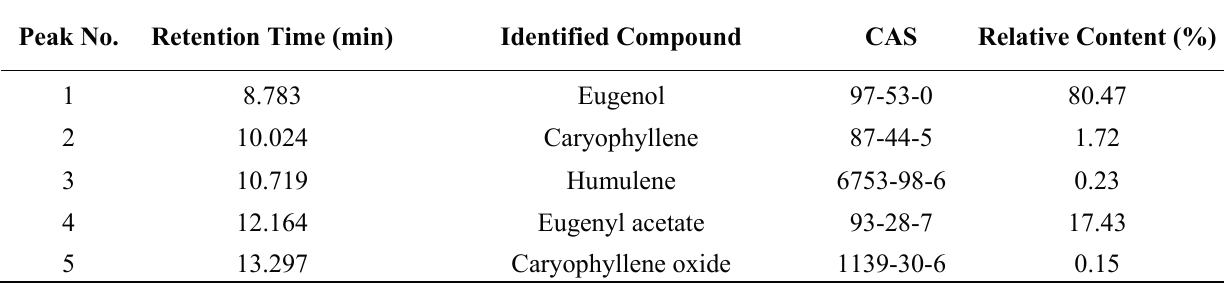
Table 5. Chemical composition of Clove